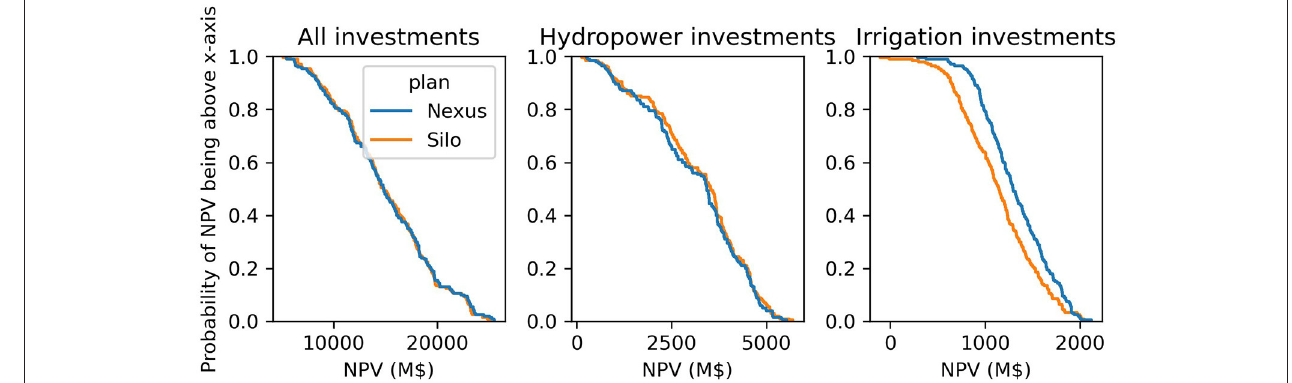
FIGURE 12 | Investment plan reanalysis. Hydropower investments contain hydropower